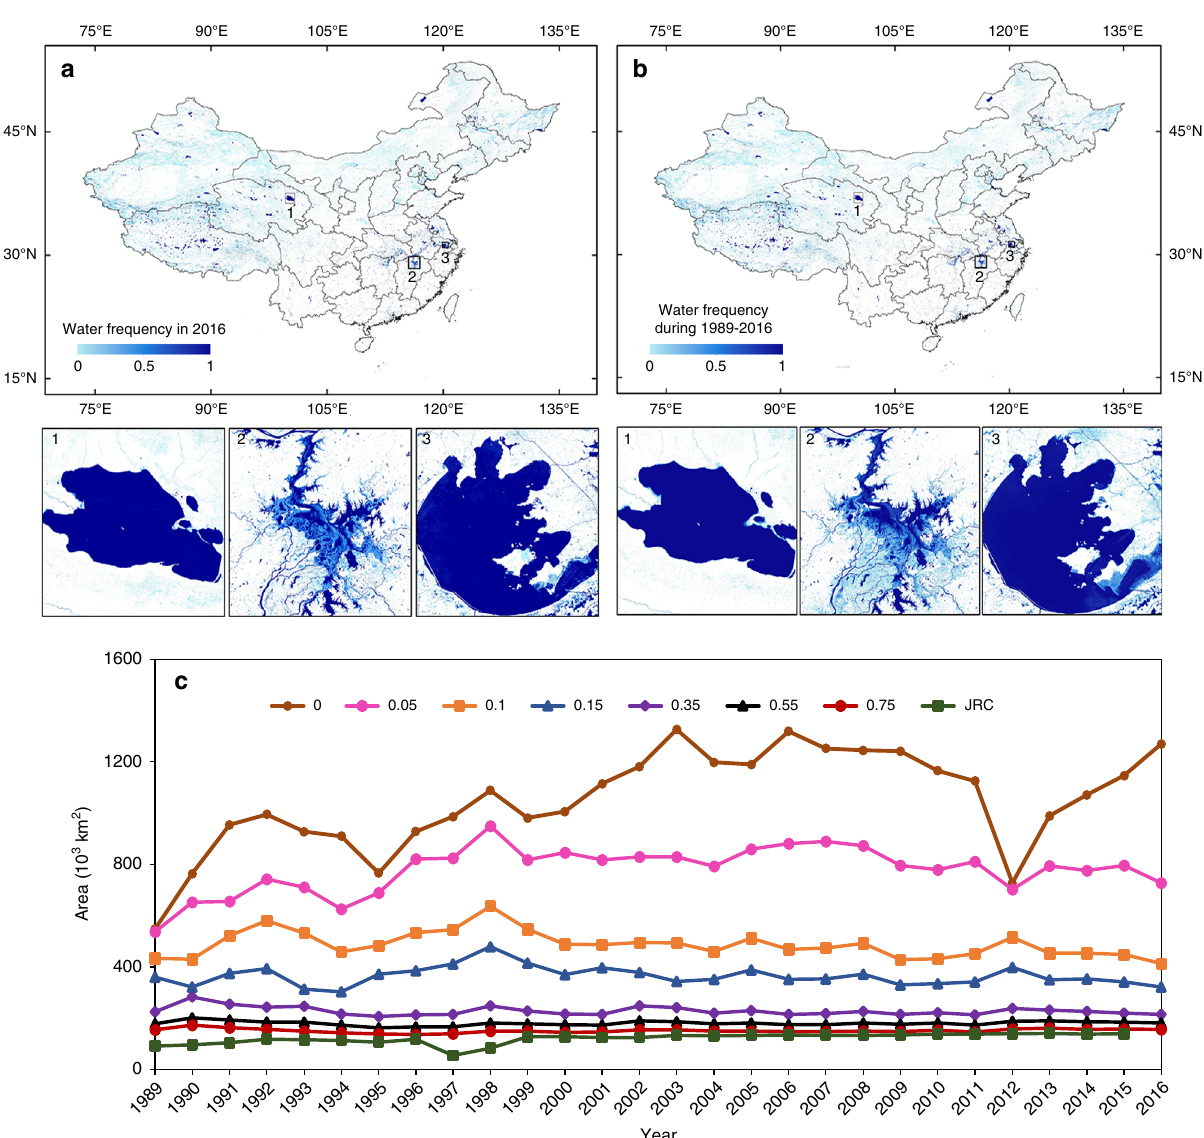
Fig. 1 Surface water body frequency maps and surface water areas using different frequency thresholds in China. a Surface water body frequency map in 2016 for China, and (1, 2, 3) are its three zoom-in views for Qinghai Lake, Poyang Lake, and Taihu Lake, respectively. b The 28-year surface water body frequency map during 1989 – 2016. c Water body areas within China during 1989 – 2016 with different annual water frequencies. The permanent water body areas from the Joint Research Centre (JRC) data set 2 during 1989 – 2015 are also